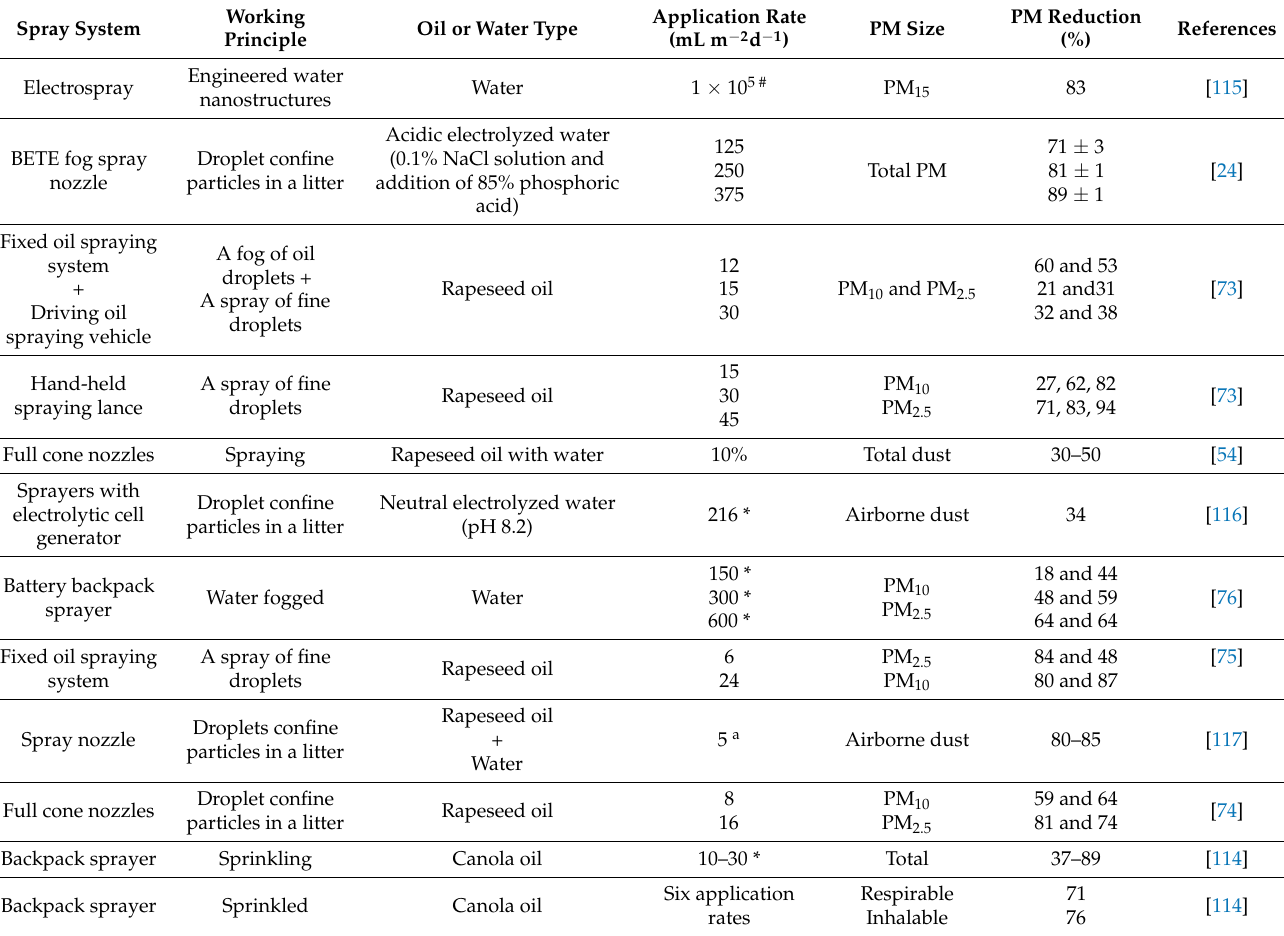
Table 9. Particulate matter reduction with liquid